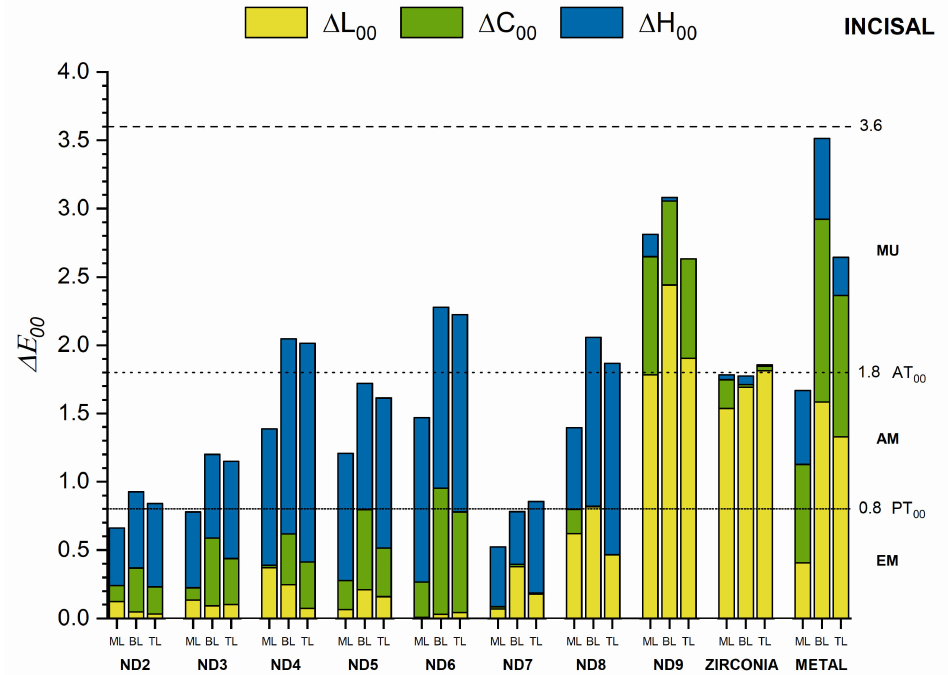
Figure 8. Masking ability of crown groups on different substrates evaluated for the incisal area. The lowest masking ability was found for ND9 and M substrates in all areas. In this case, the color differences were extremely unacceptable (EU) in the cervical and middle areas (Figures 6 and 7). For substrates ND2-ND6, the differences in hue ( ∆ H 00 ) and chroma ( ∆ C 00 ) from the ND1 substrate contributed the most to the total color difference. For ND7 and ND8, the differences in lightness ( ∆ L 00 ) and hue ( ∆ H 00 ) had the most significant influence, while for ND9, Zr, and M substrates, the lightness ( ∆ L 00 ) and chroma ( ∆ C 00 ) differences contributed to the most to the color difference. This behavior was found in all three areas of the